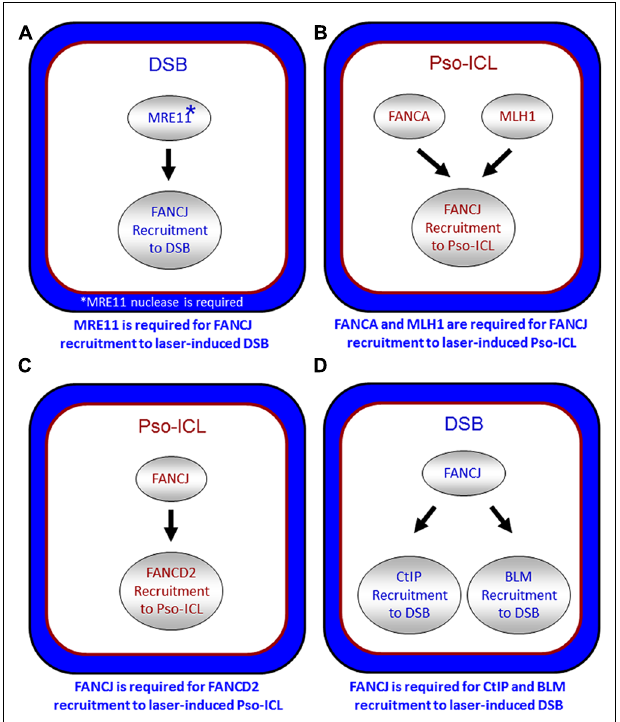
FIGURE 5 | Spatio-temporal recruitment of FANCJ and its protein partners to site of DNA damage. Confocal microscopy studies with living cells were used to elucidate the requirements of FANCJ or its interacting DNA repair factors to laser-induced psoralen (Pso)-interstrand cross-links (A,C) or laser-induced double strand breaks (DSB; B,D ). See reference Suhasini etal. (2013) and text for